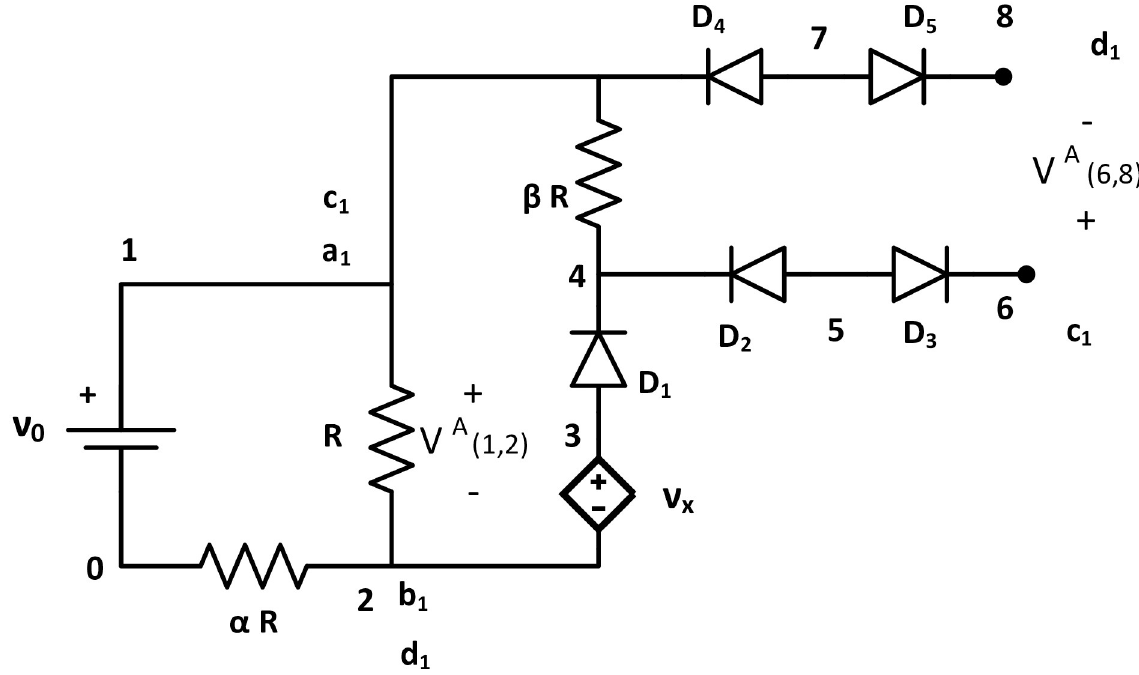
Fig 2. Seed tile A. Tile A (Seed Tile) for the bcTAM consisting with one DC voltage source ν 0 , one dependent voltage source V ideal diodes D 1 , D 2 , D 3 , D 4 , D 5 with τ = 0, and three resistors ( R , α R , and β R where β R is a large value resistor compared to R and α R ). It has two output terminals across node {1, 2} and node {6, 8}. Node 1 has glue { a 1 , c 1 }, node 2 has glue { b 1 , d 1 }, node 6 has glue c 1 , and node 8 has glue d 1 .